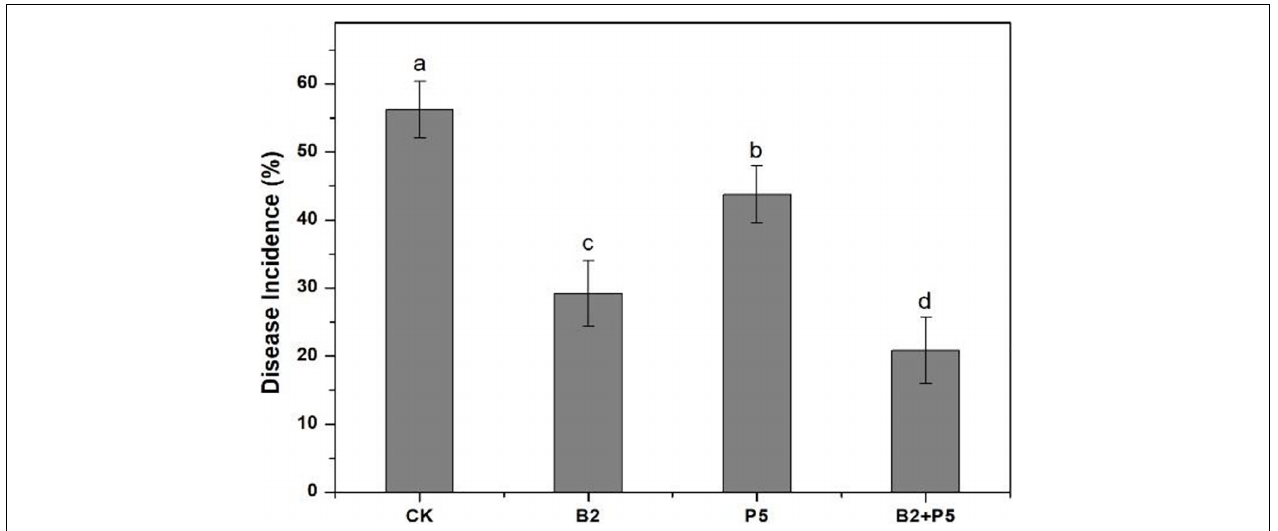
FIGURE 7 | Effect of different treatments on the disease incidence of Fusarium wilt of cucumber seedlings at 60 days after transplanting. Treatments: CK, without any microbial treatment; B2, inoculation with Bacillus amyloliquefaciens B2; P5, inoculation with Pleurotus ostreatus P5; B2 + P5, co-inoculation with B. amyloliquefaciens B2 and P. ostreatus P5. Different letters above each bar indicate significant differences ( p < 0.05; Duncan’s test) among treatments.